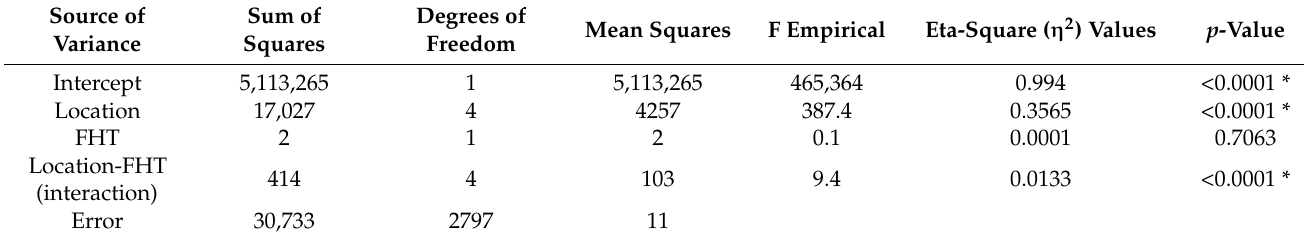
Table 11. Effect on wood hardness of location and habitat type and the interaction between these factors (two-way analysis of variance).